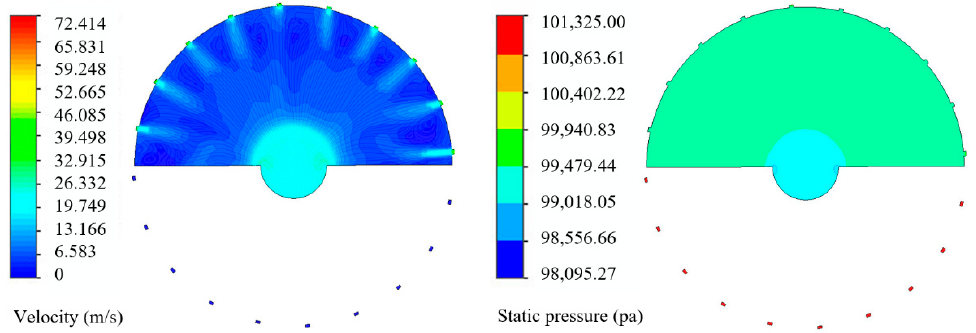
Figure 4. Simulation model of the flow field of a seed dispenser.